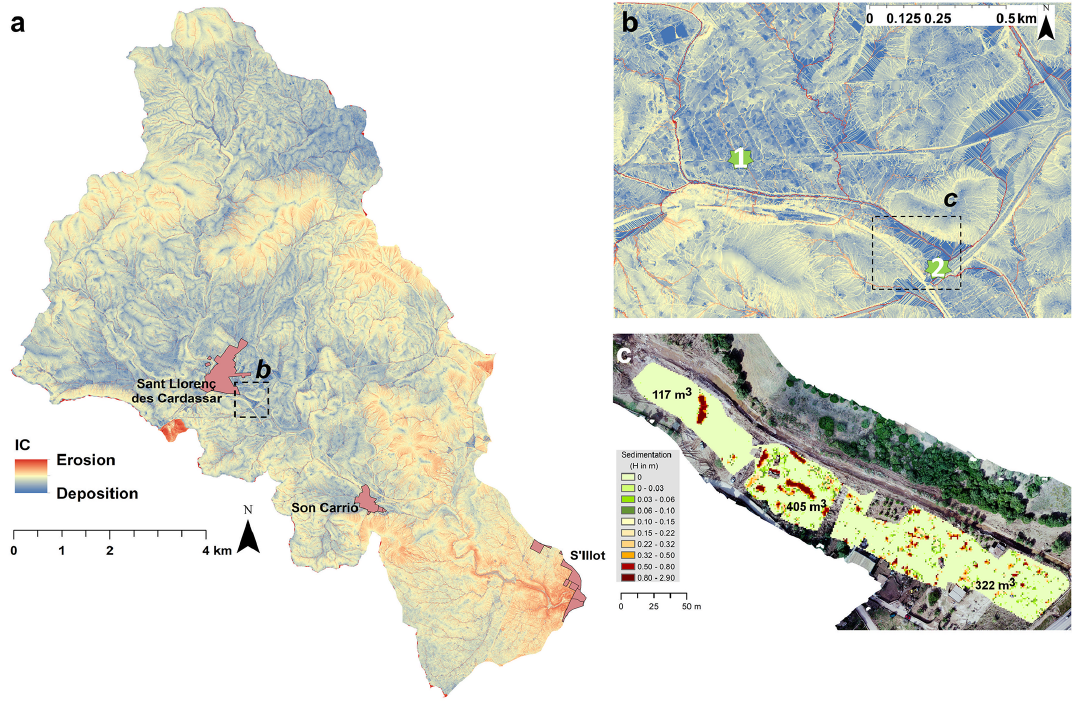
Figure 9. Spatial patterns of hydrological and sediment connectivity (deposition zones in blue colours) (a) in the Ca n’Amer River basin, (b) in the southeastern part of Sant Llorenç des Cardassar with numbers indicating (1) the point where the missing person was last seen and (2) where this person was found by using this connectivity index from a 2m resolution digital terrain model (DTM) (Instituto Geográfico Nacional, 2014). (c) Overbank sedimentation estimated after the flash flood from a DTM performed with SfM from a UAV flight (15 Octo- ber 2018) in relation to the ground points of the 2014 lidar data. Background aerial orthophotography of approximately 2cm resolution also obtained from the drone images. Numbers indicate the total volume of deposited sediments in the three areas